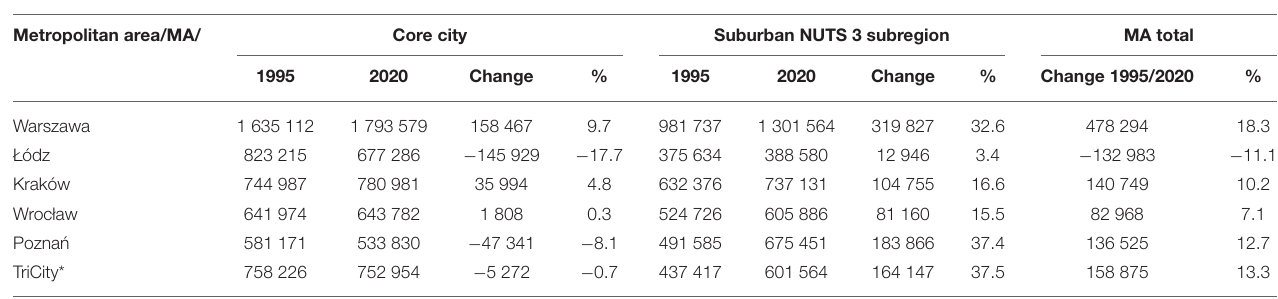
TABLE 1 | Population change 1995–2020 in major metropolitan areas of Poland. Metropolitan area/MA/ Core city Suburban NUTS 3